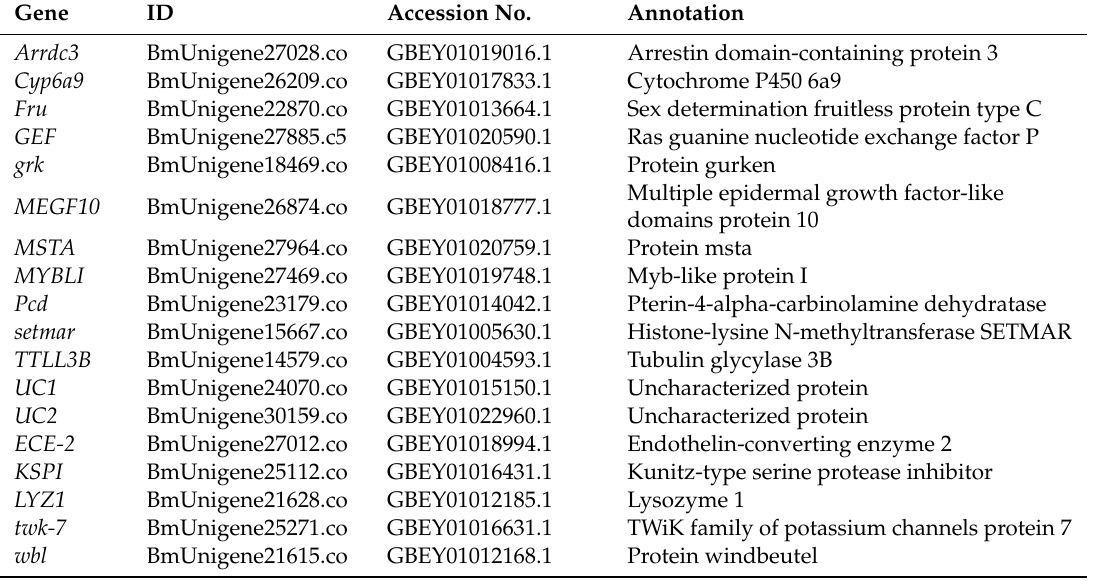
Table 1. Information of selected putative diapause-associated